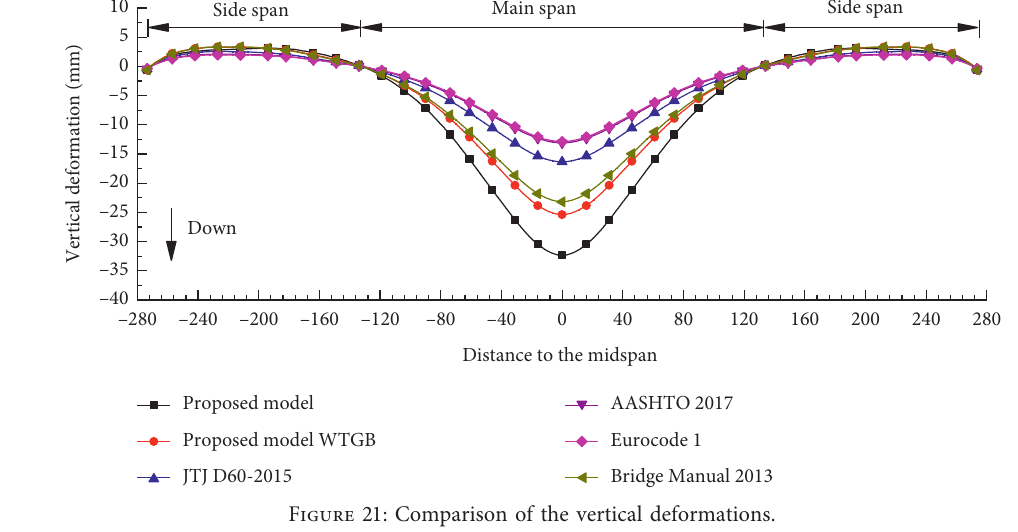
Figure 21: Comparison of the vertical deformations.